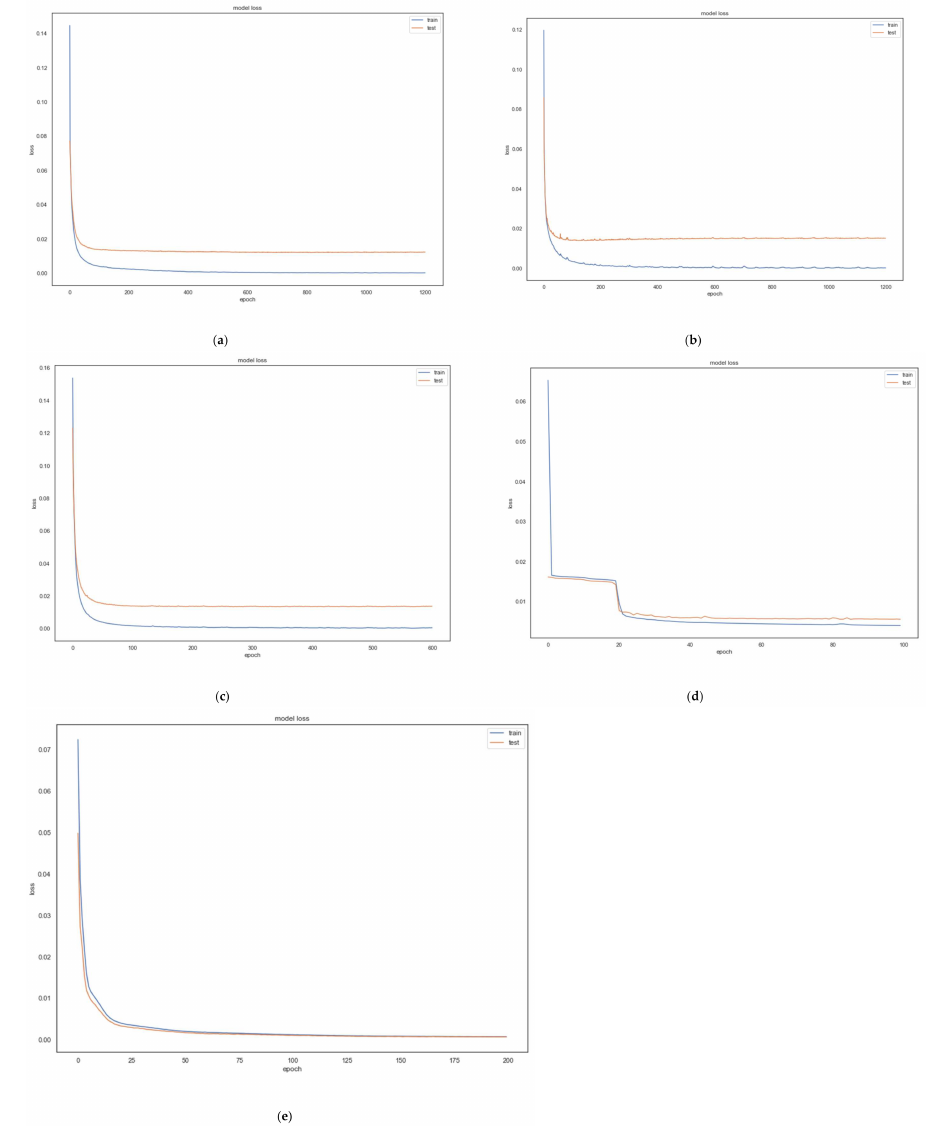
Figure 3. Autoencoder error loss vs. epochs on the five datasets: ( a ) MNIST; ( b ) Fashion-MNIST; ( c ) USPS; ( d ) MSTAR; ( e )